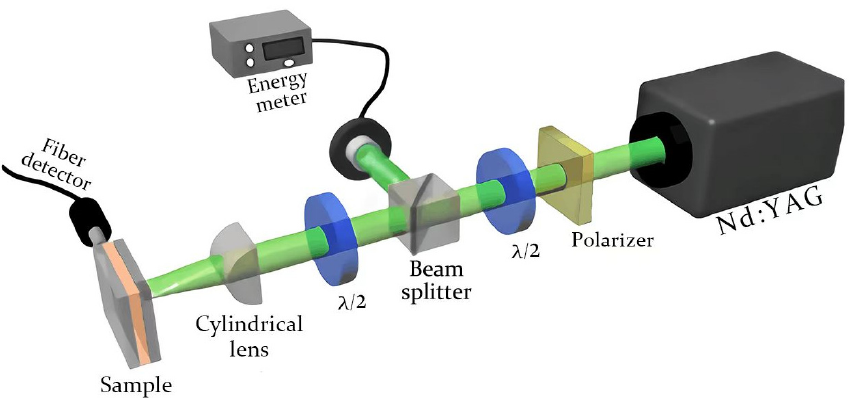
Figure 2. The experimental setup of optical measurement.